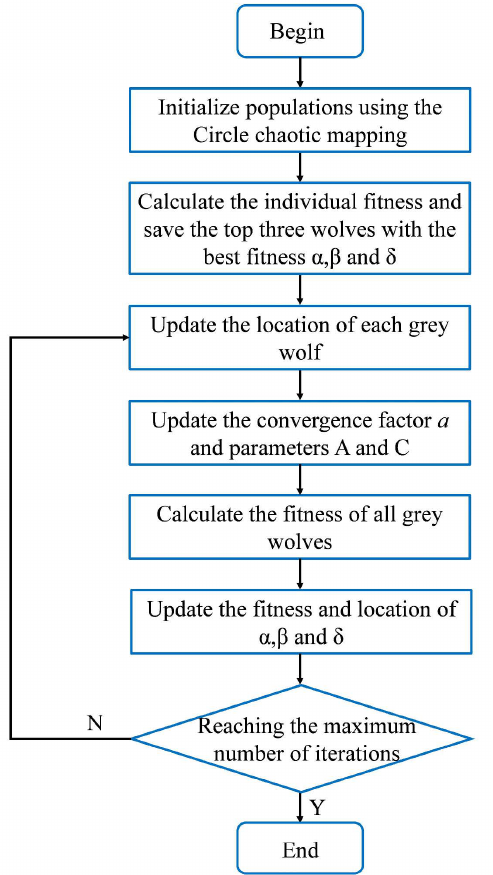
Figure 13. Flow diagram of the improved neural network structure [34].